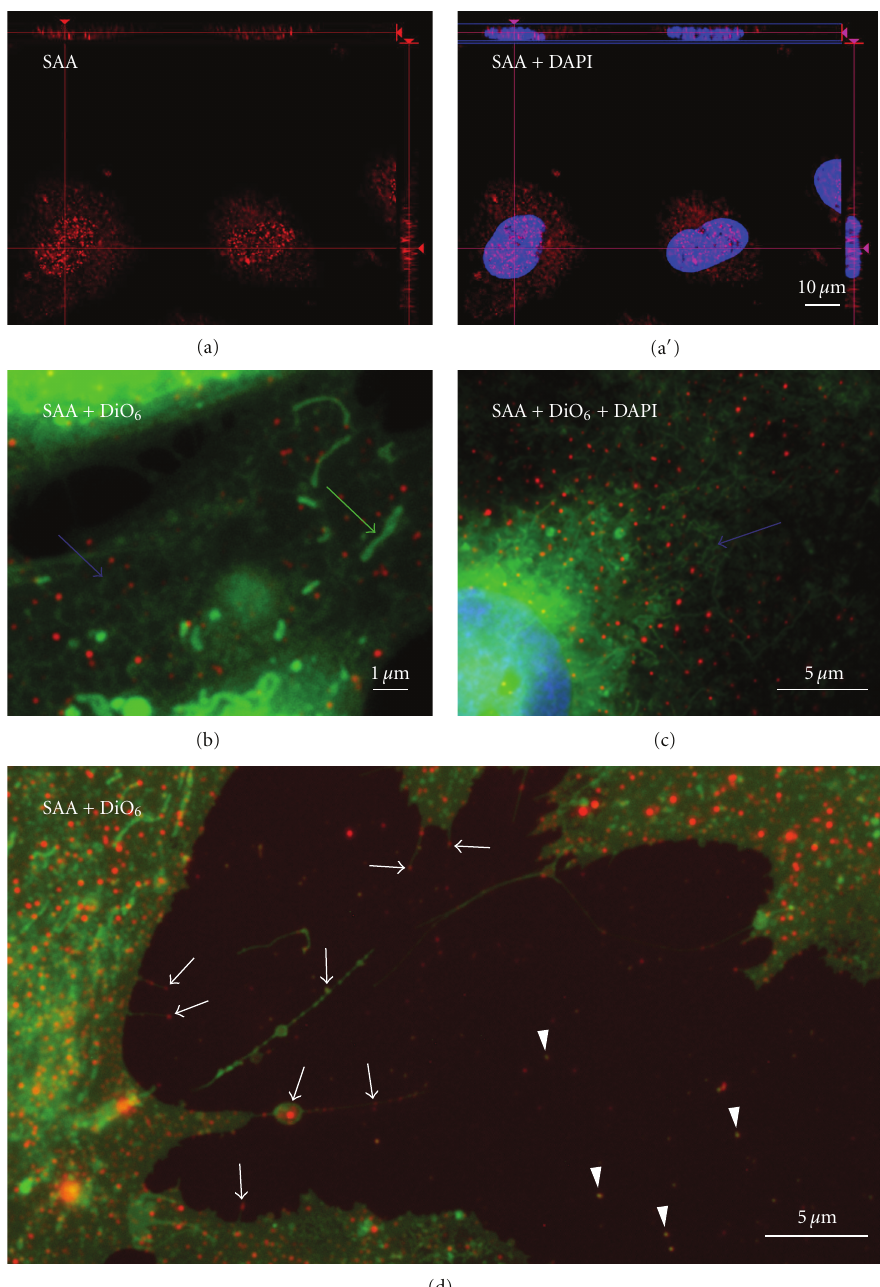
Figure 2: Staining for SAA is found in the nucleus, nanotubes, and budding vesicles; however, its association with endomembranes remains unclear. SAA in HCAEC shows a predominantly nuclear localization, with a strong signal also concentrated in the juxta-nuclear cytoplasm (a (cid:4) ). In (a) and (a (cid:4) ) the cut views above and on the right of each panel represents the SAA mainly inside nuclei and in the perinuclear space. In HCAEC nuclei were stained with DAPI (blue), endomembranes were stained with 3,3 (cid:4) -dihexyloxacarbocyanin iodide (DiO 6 ) (green) and SAA was labeled with anti-SAA antibodies (red) (c). Merged labeling indicates SAA staining distinct from the endomembranes (b) and (c). Endoplasmic reticulum is shown by the purple arrows, mitochondrion with the green arrow. HCAEC were stained with DiO 6 and show colocalization of SAA with nanotubes (d). SAA was clearly detected at the tips of the filopodial protrusions (white arrows), and in vesicles dispersed outside the cells (white arrowheads). The association of SAA with endomembranes remains unclear. Anti-SAA poly- clonal antibodies 3, 5, and 6, which target SAA peptides with amino acid sequences 27–44, 59–72, and 68–84, respectively, were used in the designated SAA